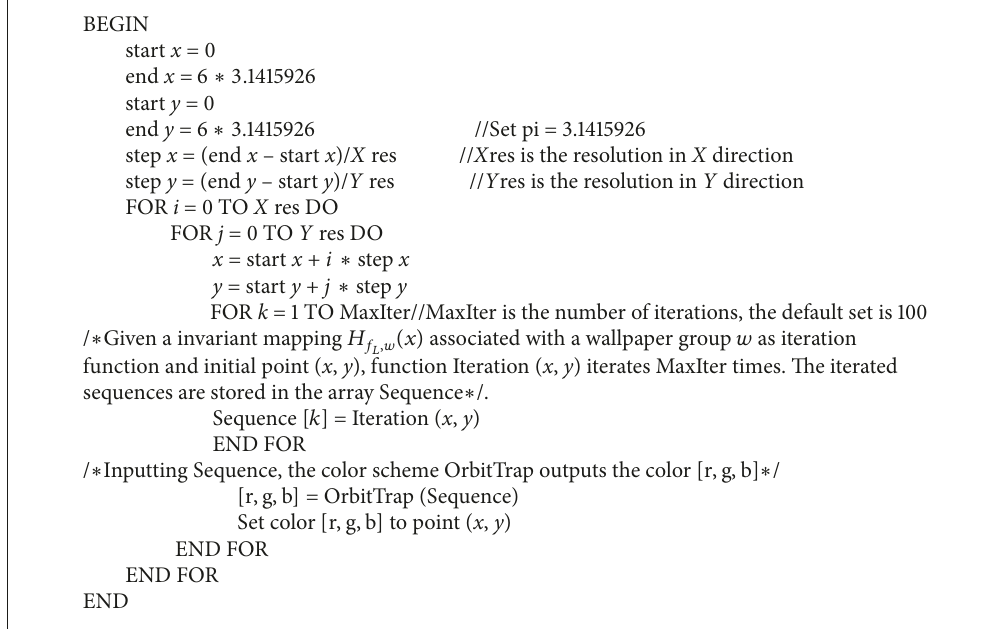
Theorem 3 can be used to create wallpaper patterns